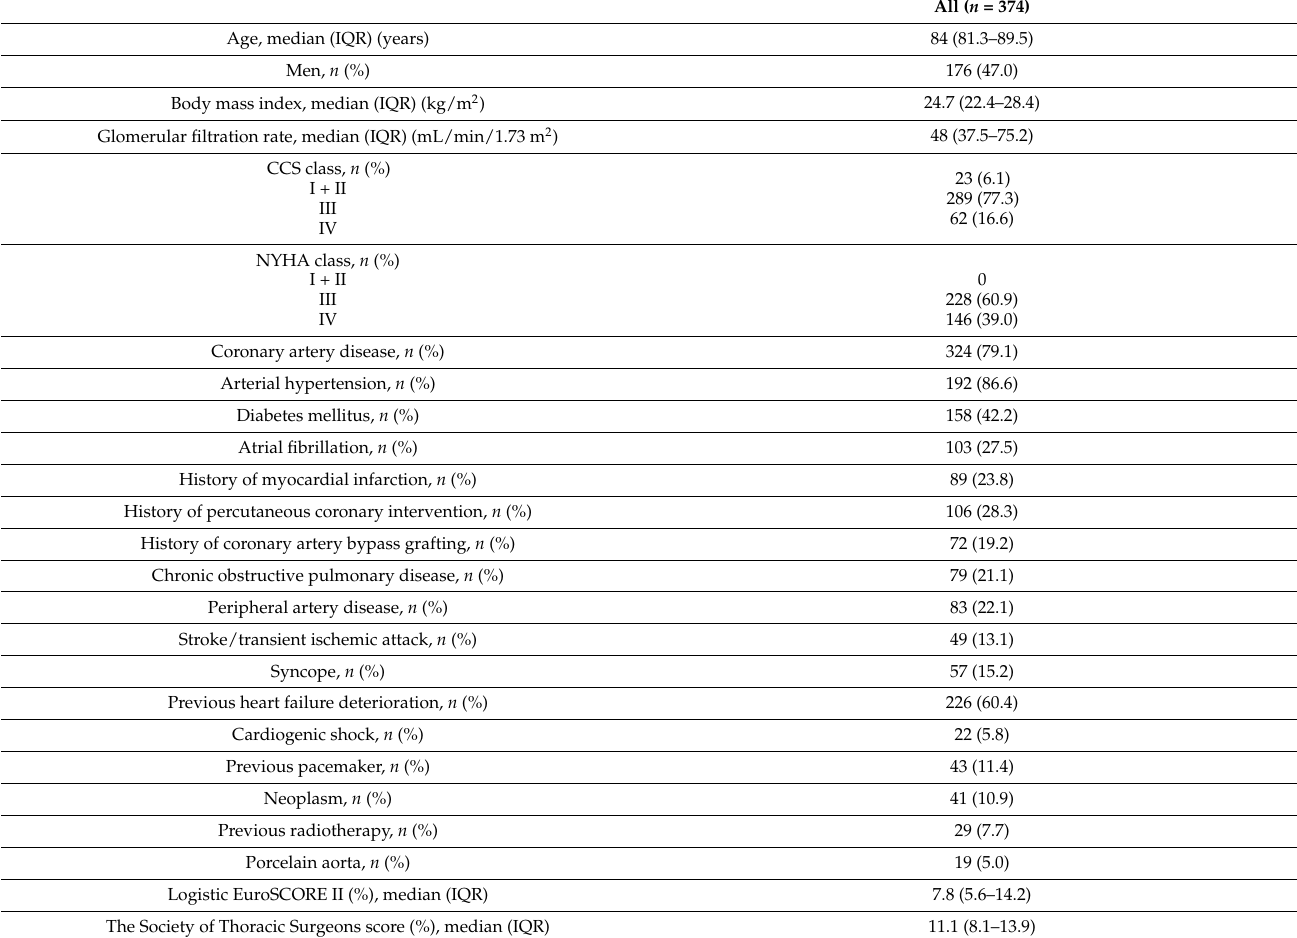
Table 1. Baseline clinical characteristics.